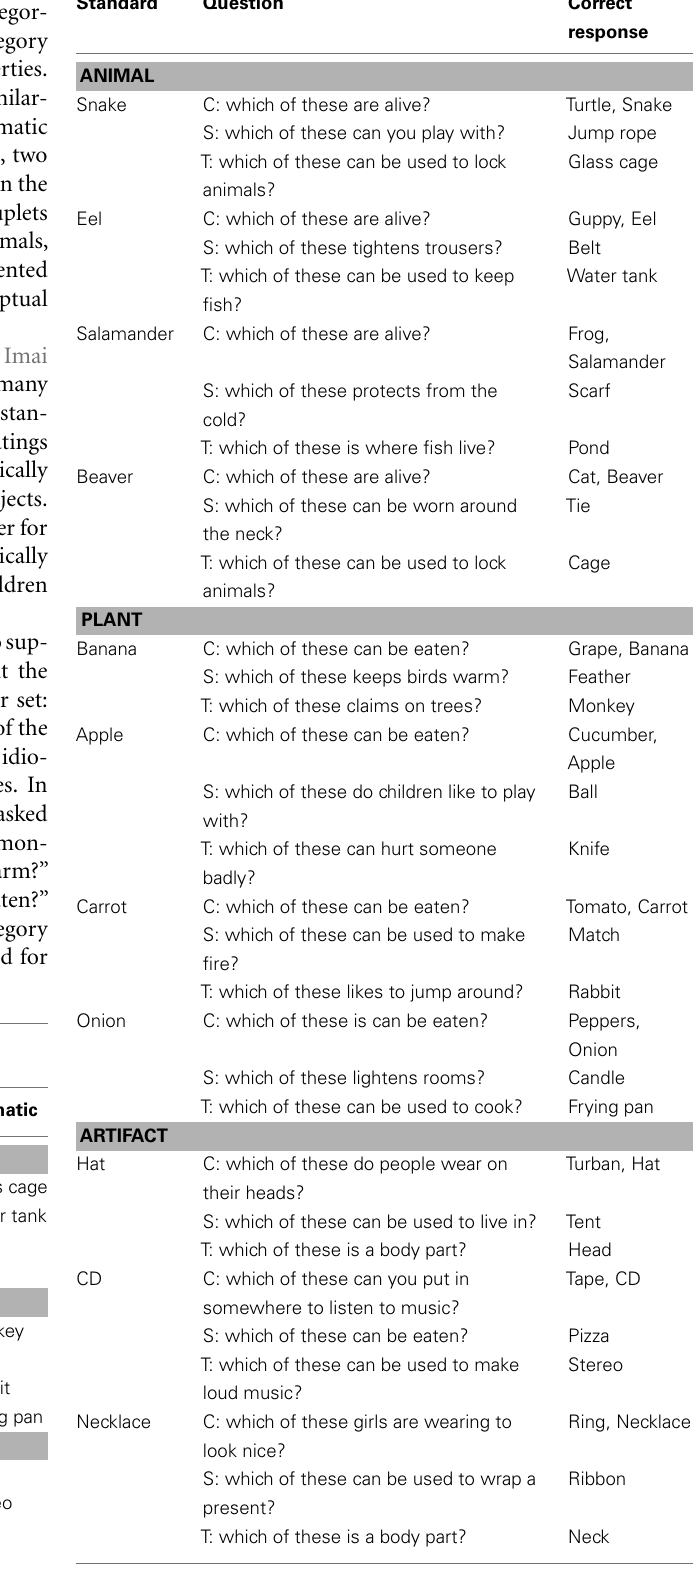
Table 2 | Knowledge triggering questions used in Experiment 1 and